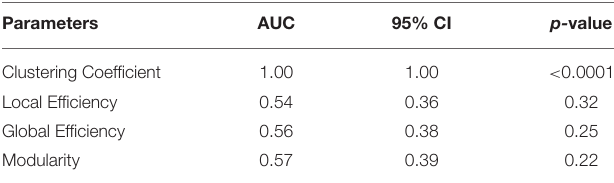
TABLE 3 | The receiver operating curves (ROC) analyses results of the gray matter for the validation of no overfitting in this study. Parameters AUC 95% CI p- value Clustering Coefficient 1.00 1.00 < 0.0001 Local Efficiency 0.54 0.36 0.32 Global Efficiency 0.56 0.38 0.25 Modularity 0.57 0.39